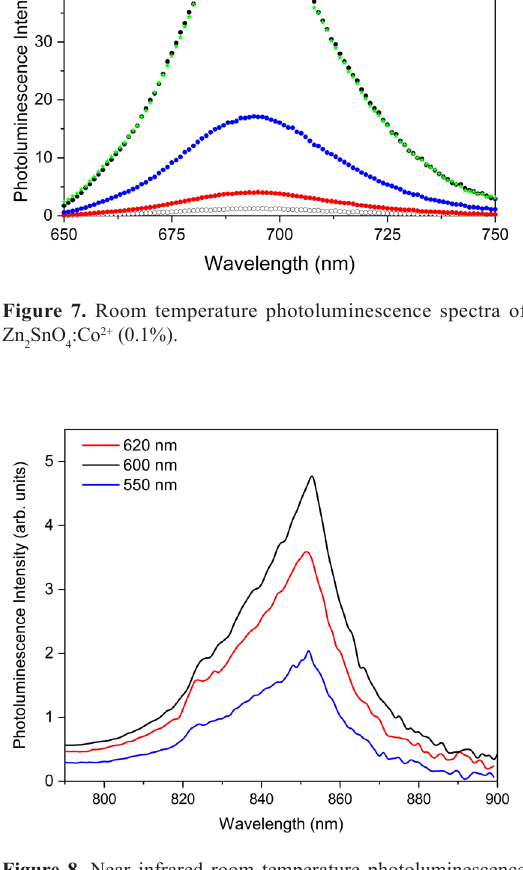
Figure 8. Near infrared room temperature photoluminescence spectra of Zn SnO :Co 2+ (0.1%). 2 4